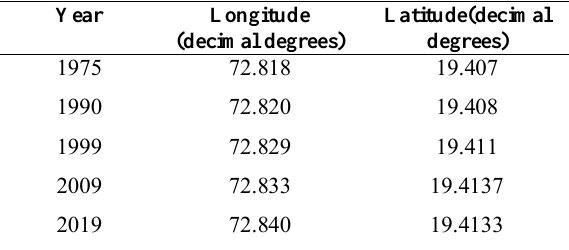
Table 1. Temporal Geometric Built-up